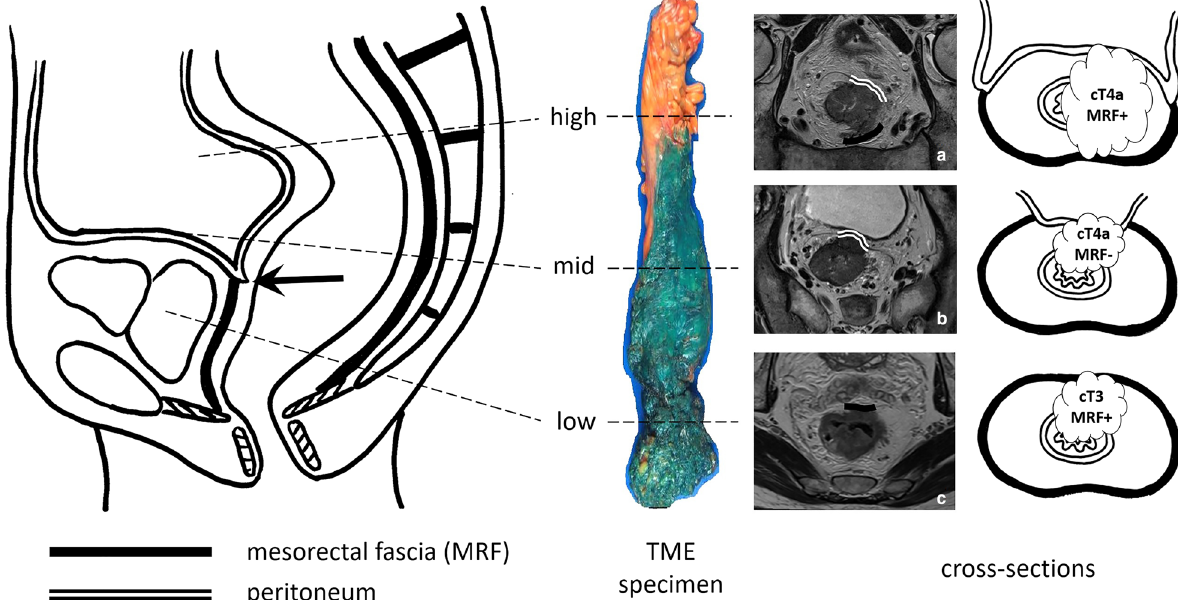
Fig. 8 Schematic drawing and total mesorectal excision (TME) resection specimen showing the mesorectal fascia (inked in green in TME specimen) extending up until the level of the peritoneal reflection (black arrow) anteriorly. From this level upwards, the mesorectum is covered by peritoneum anteriorly in the mid‑rectum, and anterolaterally in the high rectum. Invasion of the peritoneum including the anterior peritoneal reflection entails cT4a disease ( a , b ). Invasion of the MRF is classified as cT3 MRF disease. Note that invasion of the MRF may co‑occur with invasion of the + peritoneum, in which case the tumour stage is cT4a MRF ( a +